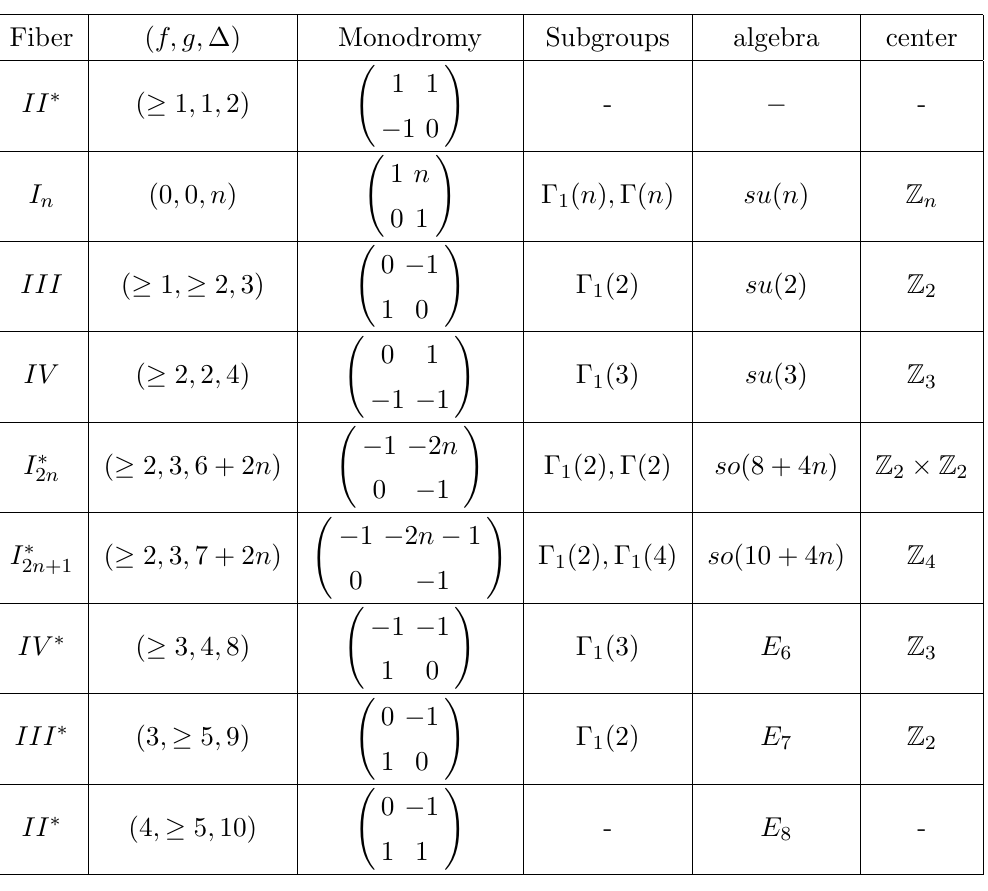
Table 1 . Summary of ADE (cid:12)ber types, their Weierstrass singularity and associated sl (2 ; Z ) mon- odromy. Column four shows compatible (cid:0) 1 ( n ) and (cid:0)( n ) subgroups matching the center of the associated algebra. I n monodromies are both compatible with Z n and Z n (cid:2) Z n torsion points. To match the F-theory geometry we make the following identi(cid:12)cation of base divisors a (cid:24) K and b (cid:24) Z of su ( n ) whereas (cid:1) denotes the intersection in the (cid:20) (cid:20) (cid:20) b